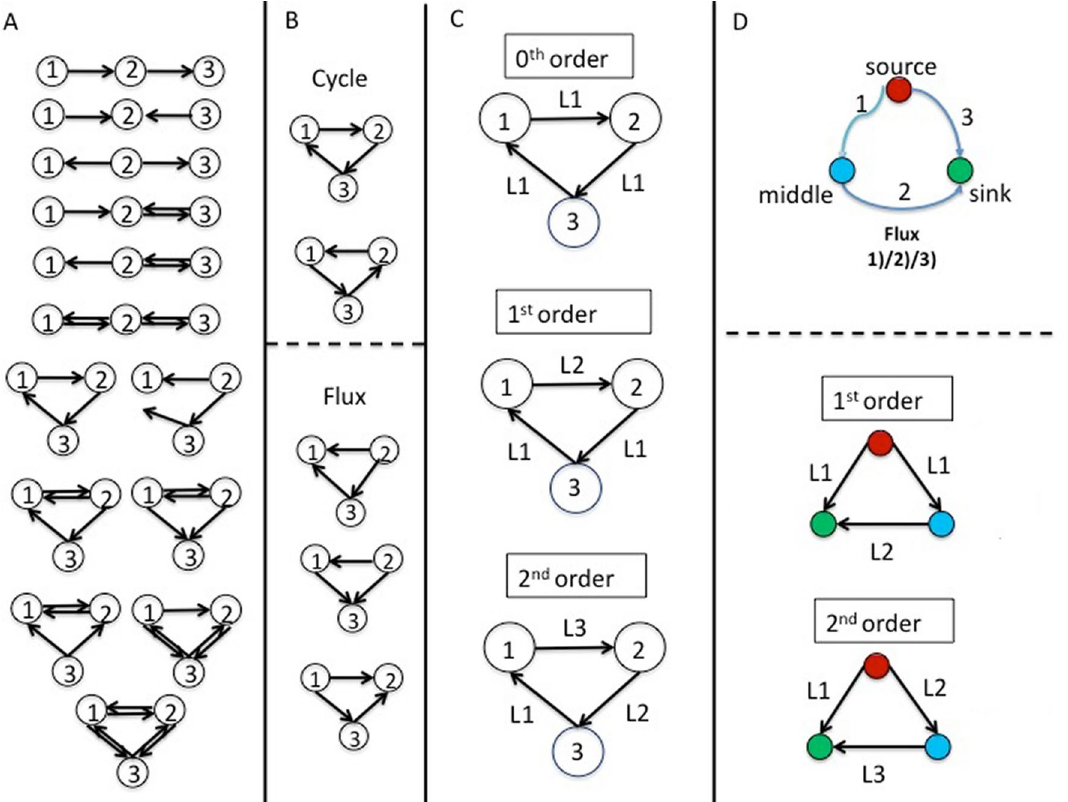
Figure 3. Triadic motifs and subgraphs. ( A ) the whole set of motifs within three nodes. ( B ) The Cycle (top) and Flux (bottom) subgraphs with the corresponding isophorms. (C) The three orders of Flux subgraphs in the multiplex network: 0 th order having all links in the same layer (M 1 ); 1 st order with two links shared in a same layer (M 1 ) and one in another layer (M 2 ); 2 nd order in which each link belongs to different layers (M 1 , M 2 and M 3 ). ( D ) Functional characterization of nodes and links in a Flux subgraph (top); Models of Flux subgraphs of 1 st and 2 nd order used in this paper (bottom). For more details see the text and Suppl. Mat. 4